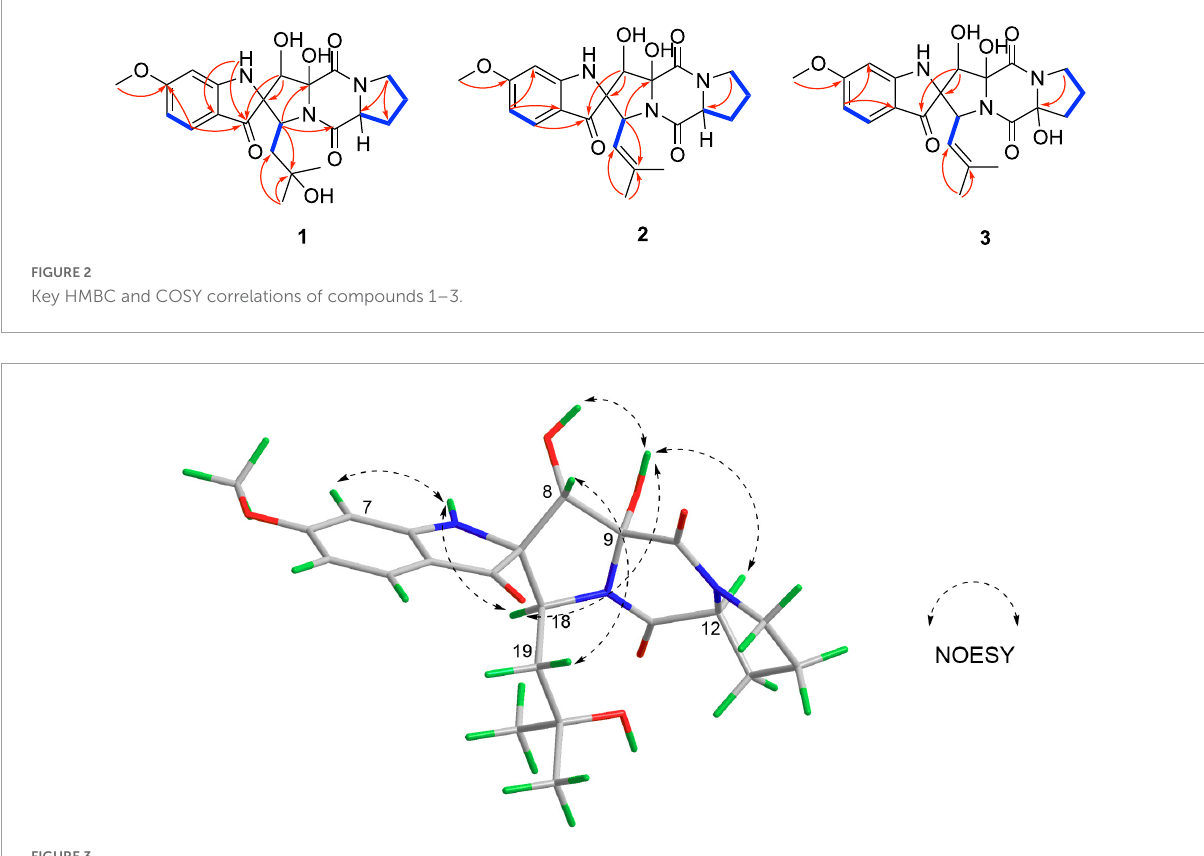
FIGURE3 Key NOESY correlations of compound